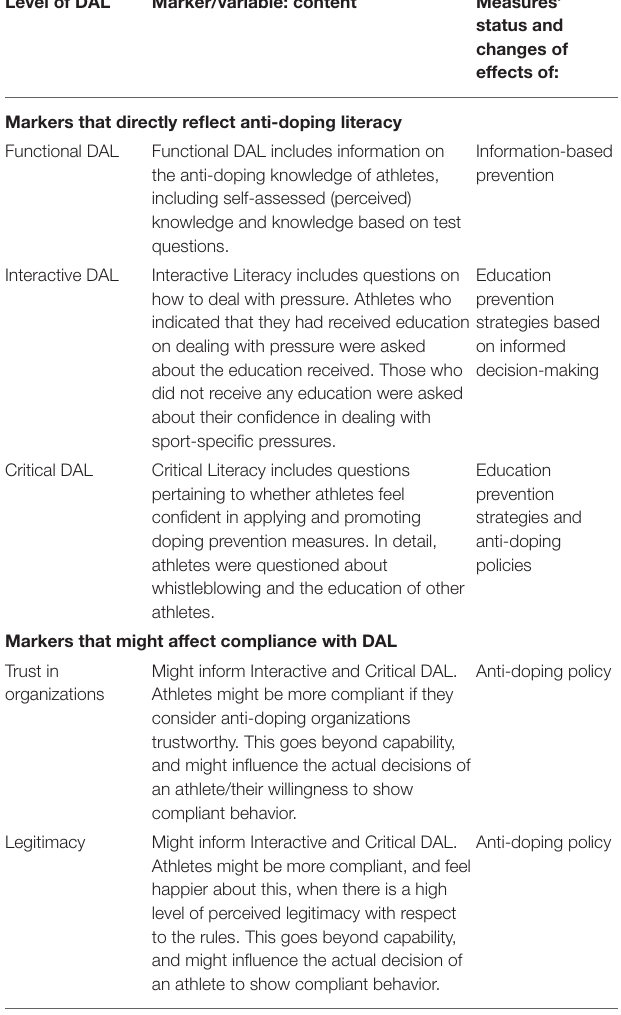
TABLE 1 | Markers to be included in GRADE